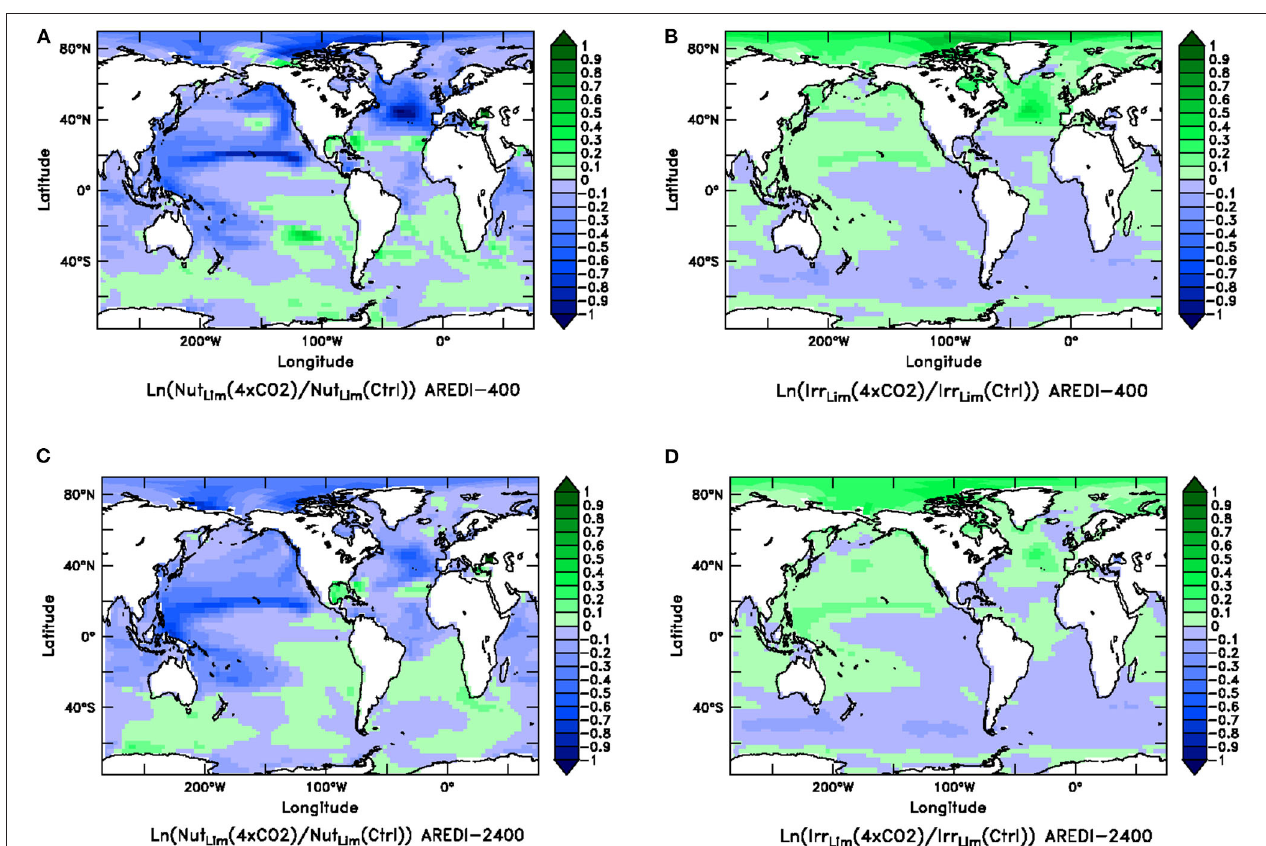
FIGURE 9 | Relative changes (natural log of the quotient of the value in century-long climatology of the 4xCO 2 run over the value in a century-long climatology of the Control) in the ratio of the quadrupled CO 2 case and the control for the nutrient limitation term (left column) and the light limitation term (right column) for the AREDI-400 case (top row) and AREDI-2400 case (bottom row). (A) Nutrient limitation for the AREDI-400 case, (B) light limitation term for the AREDI-400 case, (C) nutrient limitation for the AREDI-2400 case, and (D) light limitation term for the AREDI-2400 case. As the growth rate is the product of these terms, low values mean higher limitation, so that blue denotes lower nutrients or lower light while green denotes higher nutrients or higher